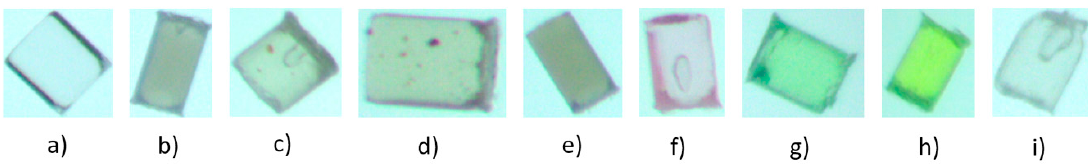
Figure 2. Representatives of each granule class: ( a ) Clean; ( b ) Blur; ( c ) Black dots; ( d ) More black dots; ( e ) Dark; ( f ) Pink; ( g ) Green; ( h ) Yellow ( i ) Material mix.